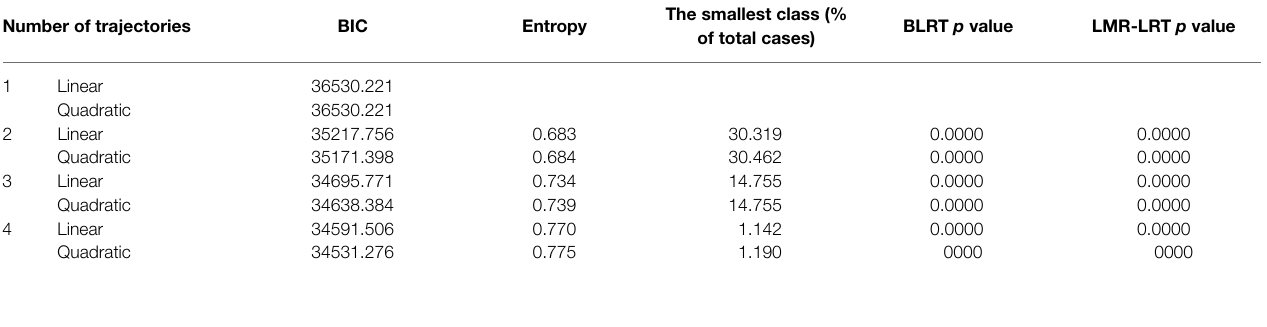
TABLE 2 | Statistical indices for 1–4 trajectories of maternal responsive parenting from child age 0 to 3. Number of